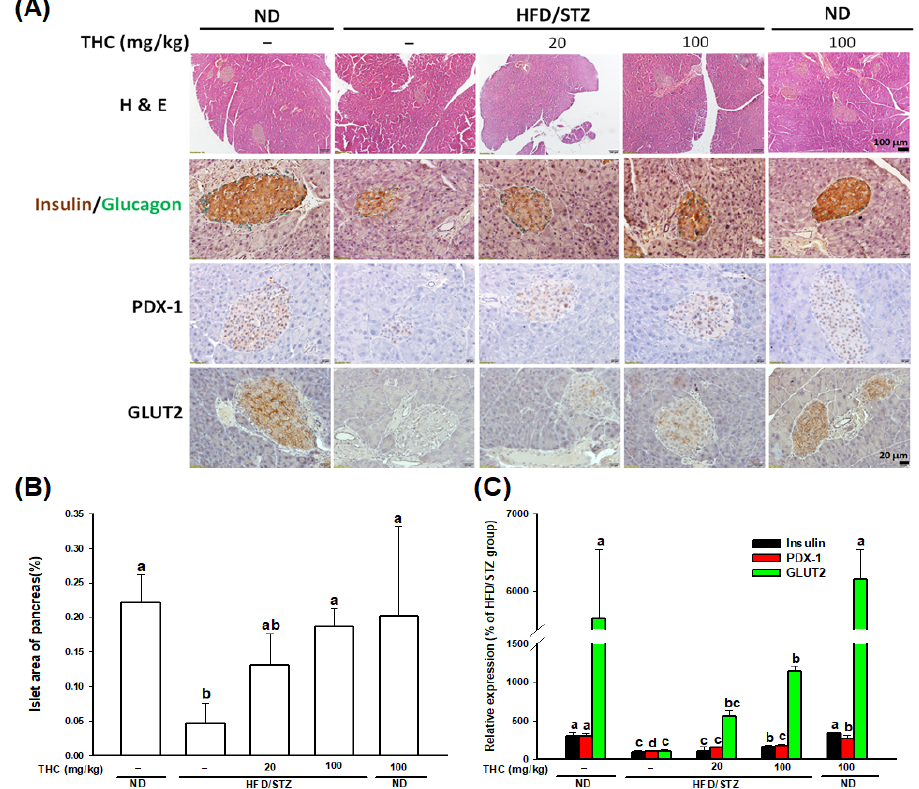
Figure 5. Effect of THC administration on pancreatic morphology, islet mass and function in HFD/STZ treated mice. ( A ) Representative images of pancreas histology by H&E staining. Islet morphology and β -cell function was examined by immunostaining with insulin ( β cells), glucagon ( α cells), PDX-1, and Glut2. ( B ) Islet area was quantified by the ImageJ and normalized to pancreatic section area. Data are expressed as mean ± SEM ( n = 5–6). ( C ) Quantification of relative insulin, PDX-1, and Glut 2 expression was performed by ImageJ. Statistical differences ( p < 0.05) between groups were evaluated by one-way ANOVA with Tukey’s post-hoc test and were labeled as different letters (a, b, and